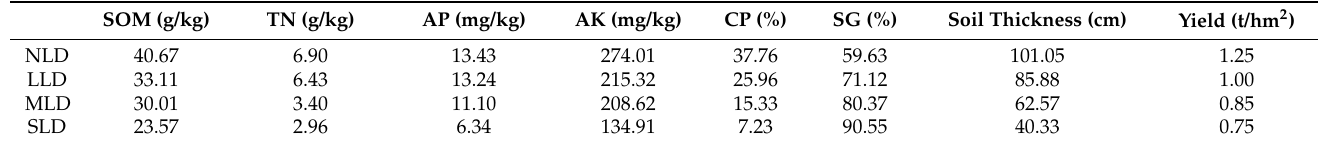
Table 1. The ecological parameters in different land-degradation